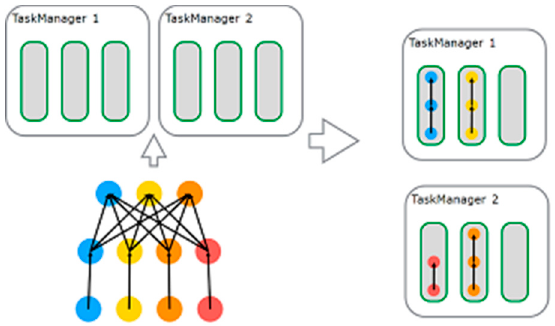
Figure 3. Distribution of operators in a distributed stream processing framework (adapted from [12]).